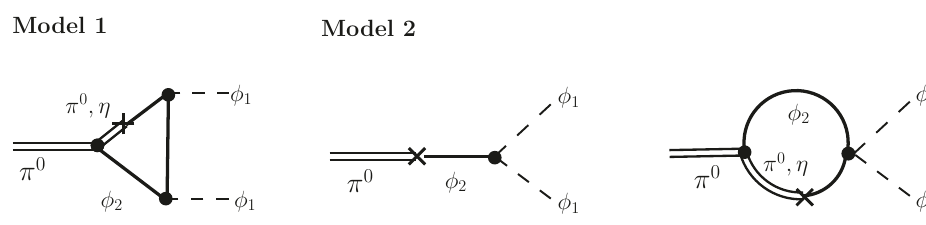
(cid:30) 1 (cid:30) 1 , in Model 1 (left) and Model 2 !